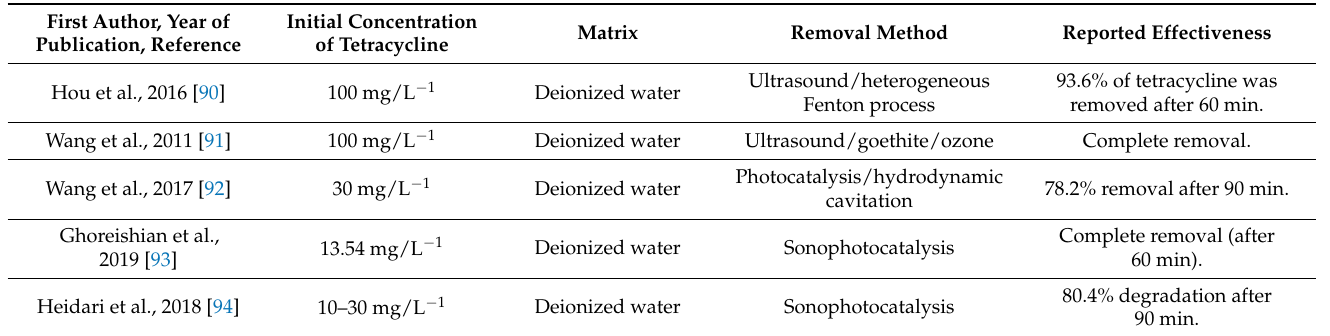
Table 2. Studies on the effectiveness of physico-chemical methods in removal of